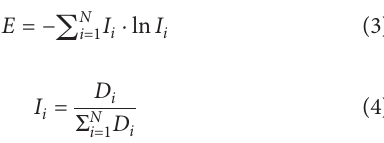
Table 1 summarized vascular network connectivity properties of the normal control group and the tumor region of HCC group.